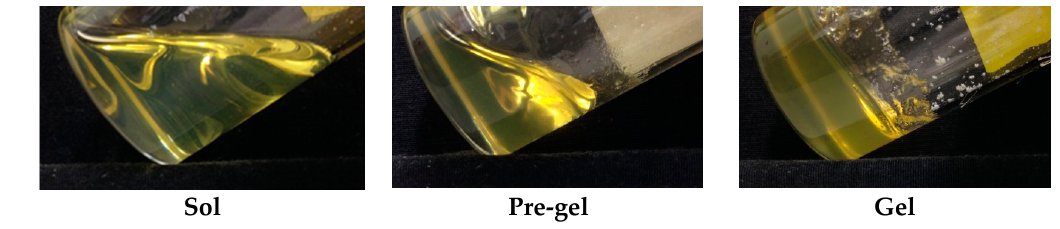
Figure 1. Visual appearance of the fumed silica (FS) suspensions in the sol, pre-gel, and gel